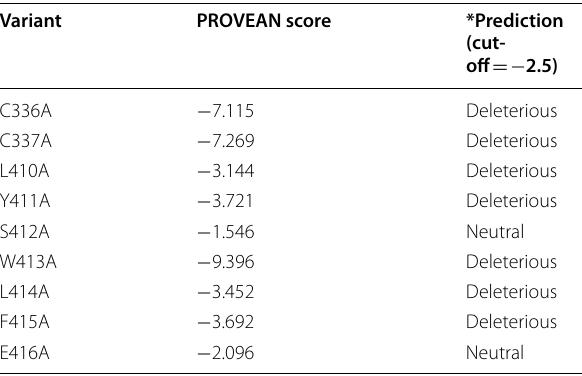
Table 7 Amino acid mutations with predicted effect using the PROVEAN